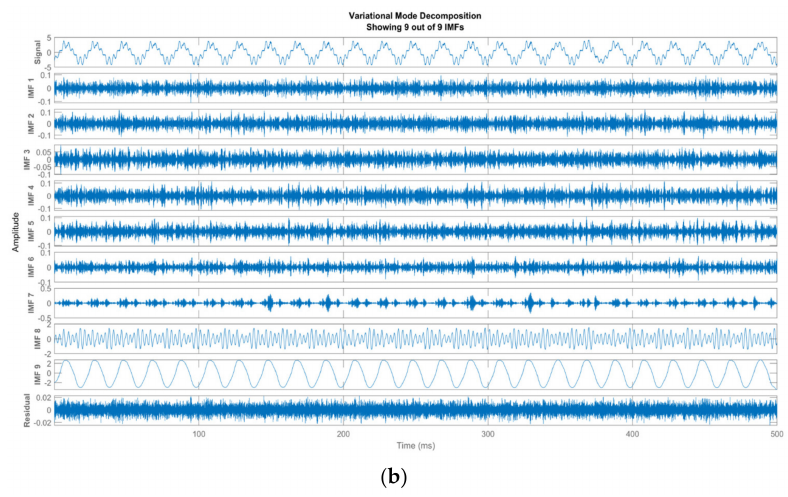
Figure 8. EMD ( a ) and VMD ( b ) decomposition of synthetic ester liquid current signal under VDE electrode arrangement (d = 2.5 mm).